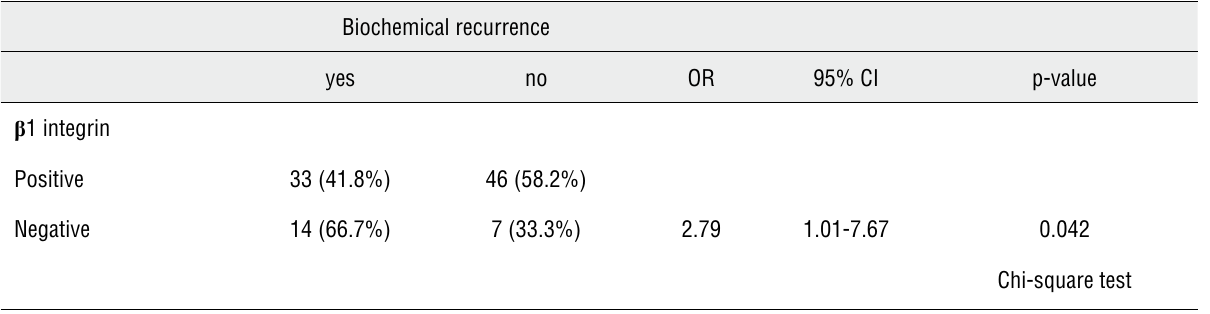
Table 5 - Univariate analysis: recurrence vs. no